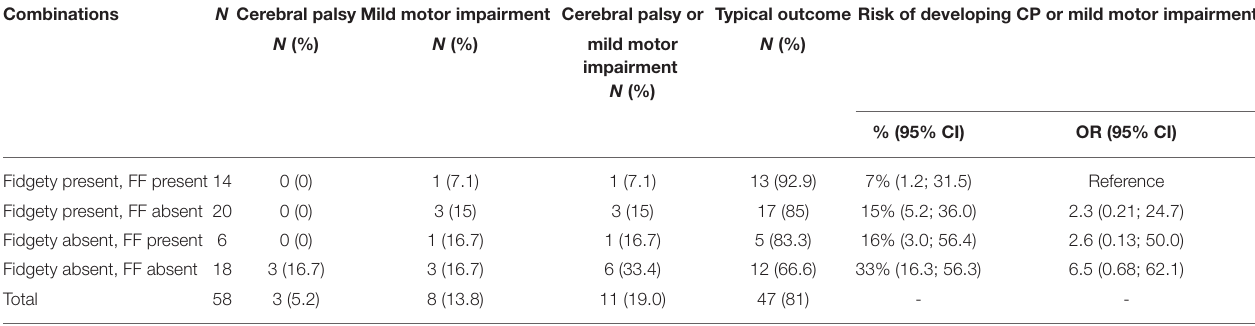
TABLE 2 | Combination of foot-to-foot contact and fidgety movements and risk of developing cerebral palsy, mild motor impairment, or both.